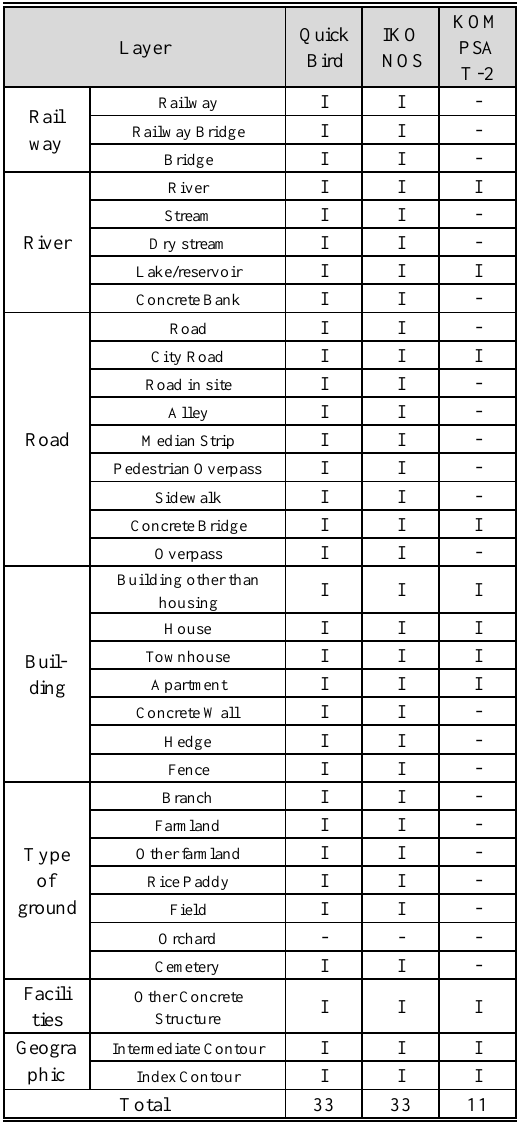
Table 5. The result of digital map generation(I: Identified, -: